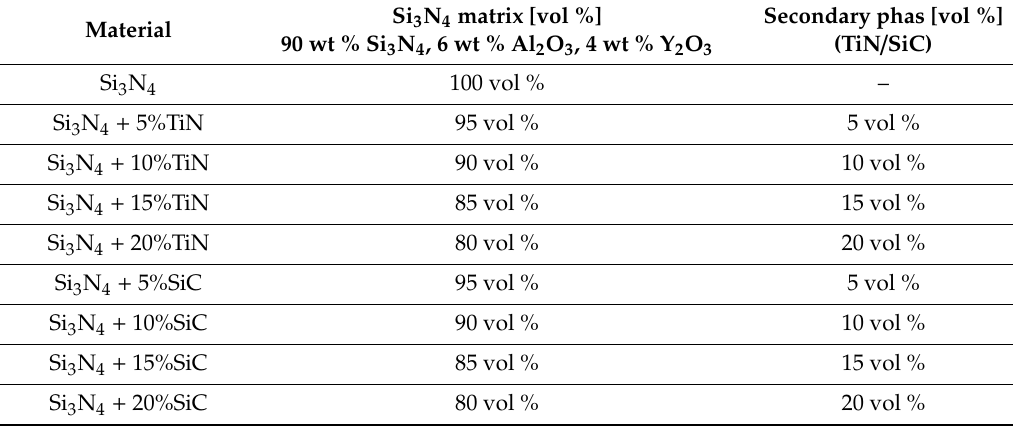
Table 1. Composition of prepared